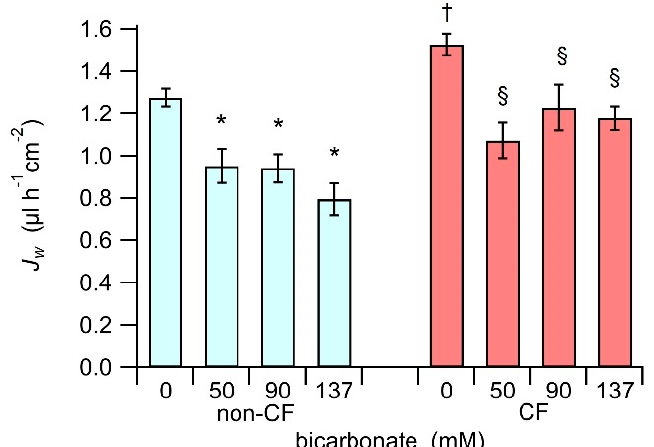
Figure 3. Fluid re-absorption, J W , of HBEC-monolayers, cultured on Snapwell permeable supports, from three different non-CF (cyan), and three different CF (red) subjects, treated with iso-osmotic solutions with different concentrations of bicarbonate. The asterisk (*) indicates that data is statisti- cally different ( p < 0.02) from the non-CF incubated with 0 bicarbonate solution; the section sign (§) indicates that data is statistically different ( p < 0.001) from the CF treated with 0 bicarbonate solution; the dagger (†) indicates that CF and non-CF cells treated in absence of bicarbonate are statistically different ( p < 0.0001).